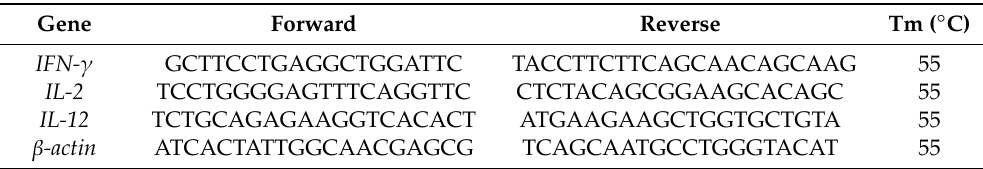
Table 1. The list of primer sequences for